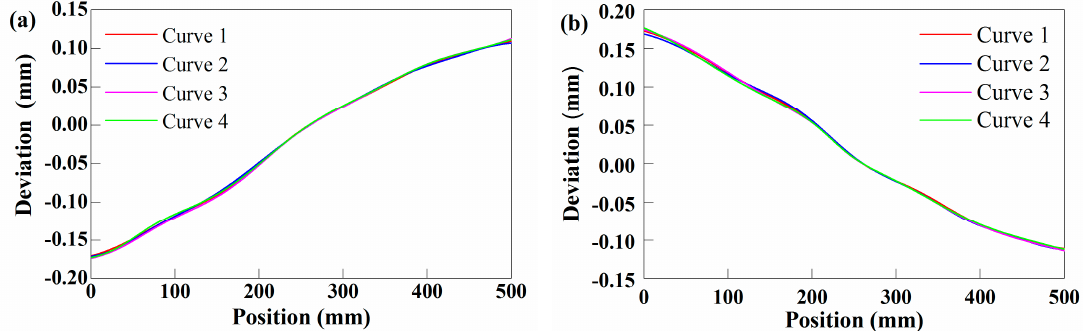
Figure 22. Combined projection curves. ( a ) PB is the measured surface. ( b ) PA is the measured surface.